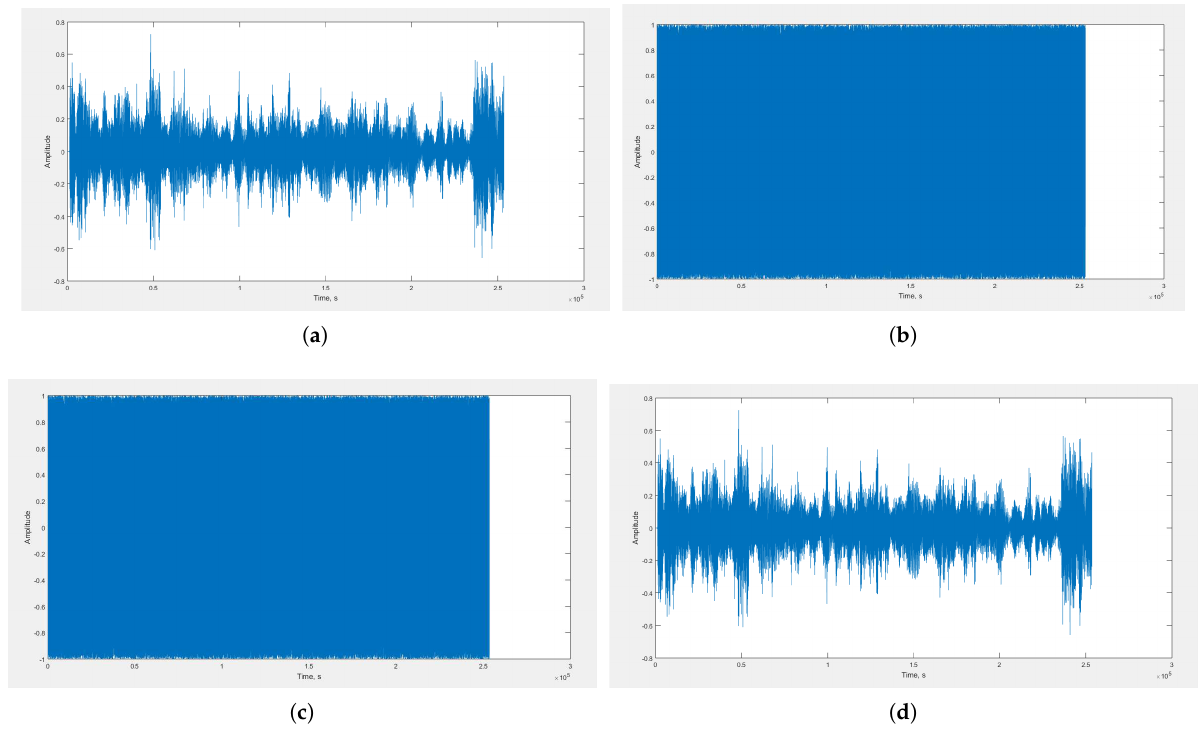
Figure 5. Waveform plotting of the original and encrypted audio file: ( a ) is the original audio file a-strange-dream; ( b ) is the encrypted audio file with the first key set; ( c ) is decrypted with a second key set; and ( d ) is the waveplot presented decrypted audio file with the first key